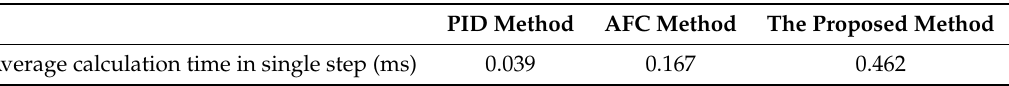
Table 5. Comparisons of quantitative evaluation indexes of the three